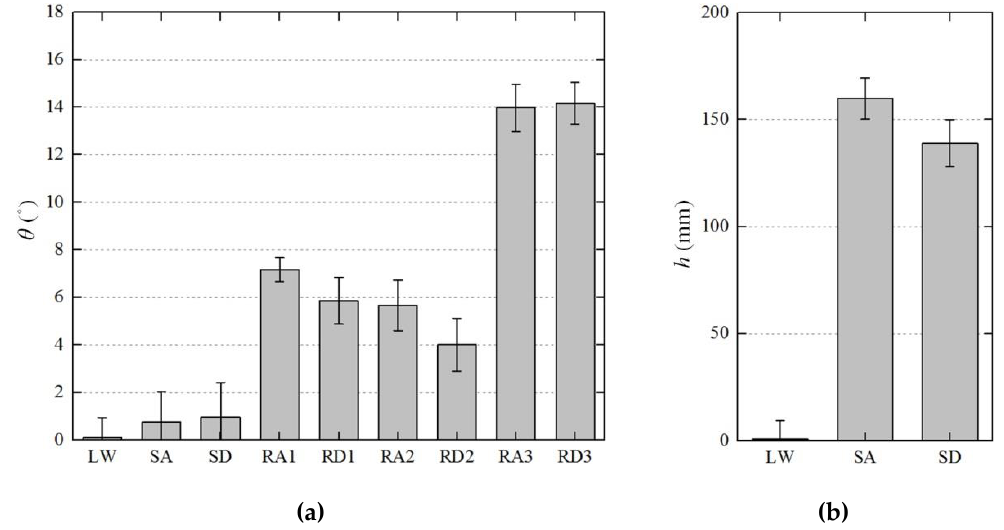
Figure 23. Average ( a ) slope and ( b ) elevation estimation results of all tests for each terrain. The absolute values were used for stairs and ramp descent cases.